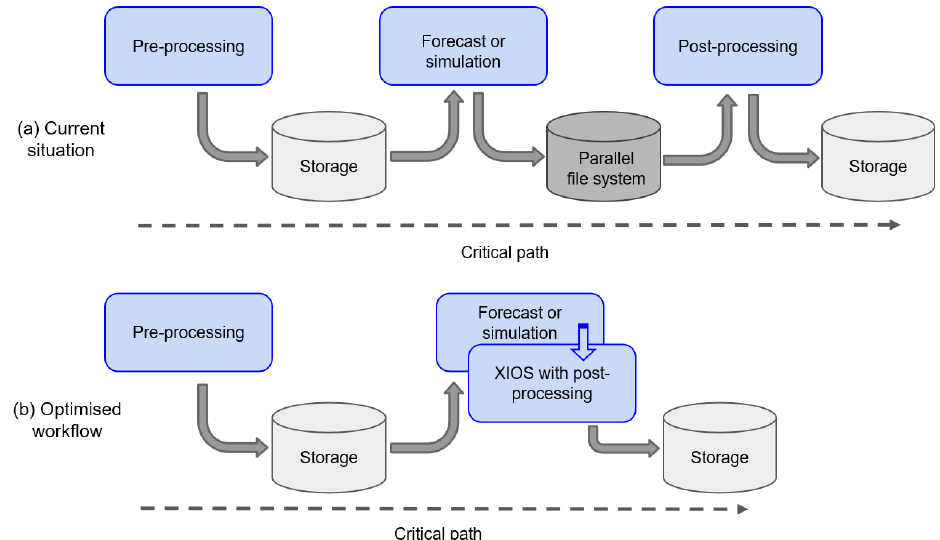
Figure 1. Schematic showing the typical key components involving pre- and post-processing of the critical path of a forecast or climate simulation. The arrows indicate the flow of the input and output. When using XIOS to perform the post-processing, the critical path is more efficient as post-processing no longer requires input/output from file system storage and post-processing happens concurrently to the